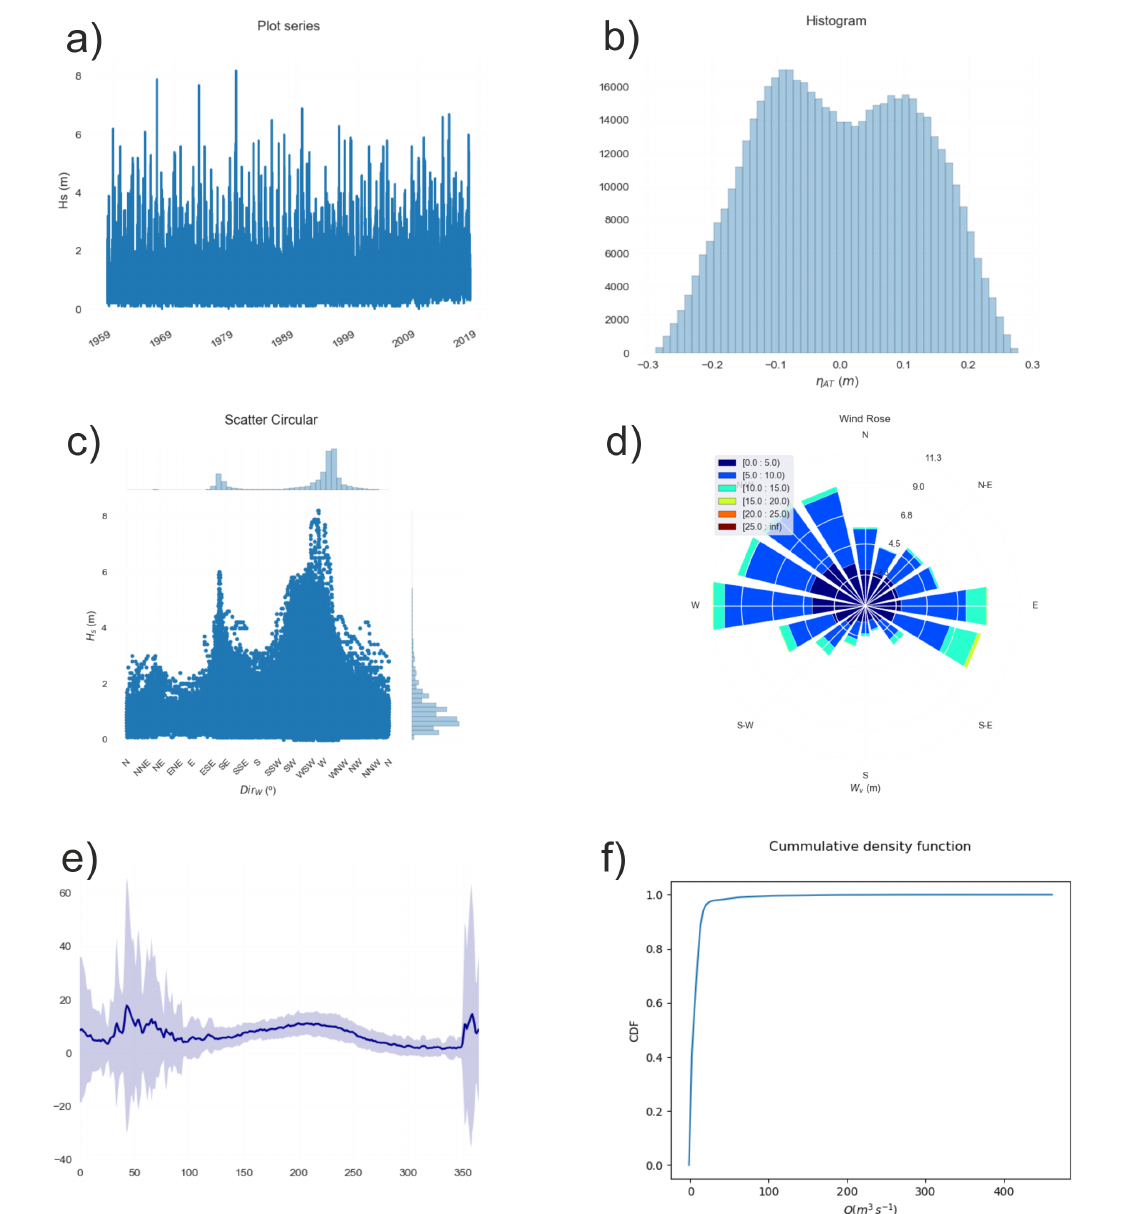
Figure 2. Graphical outputs obtained by the climate tool. ( a ) Time series plot of significant wave height. ( b ) Histogram of the astronomical tide. ( c ) Scatter plot of significant wave height and peak period. ( d ) Wind rose. ( e ) River discharge annual variability. ( f ) Empirical cumulative density function of the river